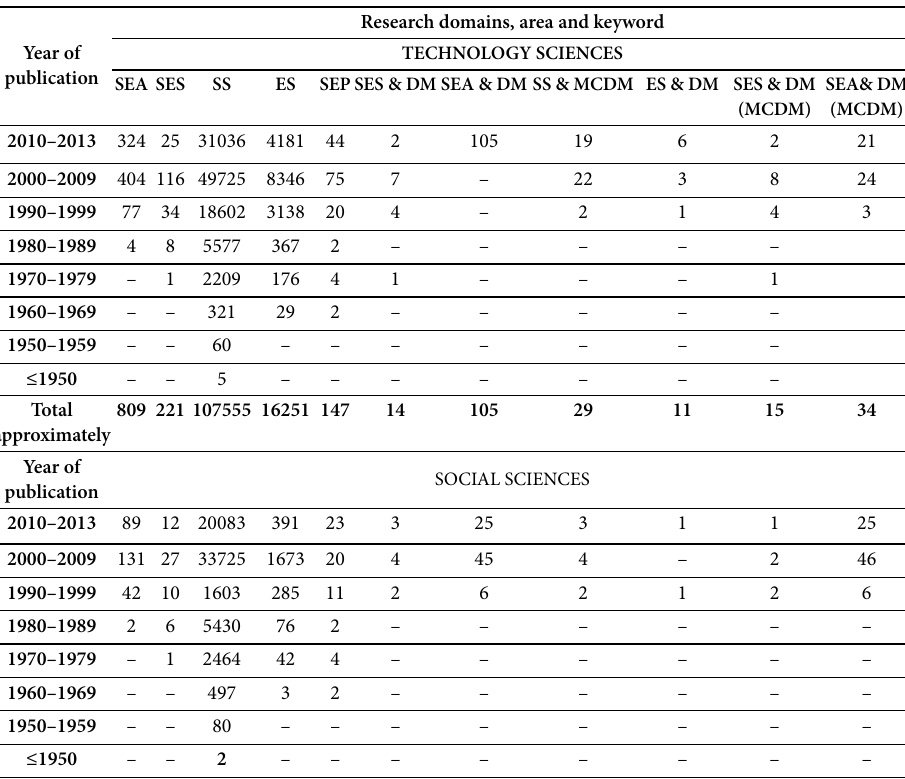
Table 1. Dynamics of the research papers in Socio-Economic Systems Socio-Economic and Decision-Making in technology and social